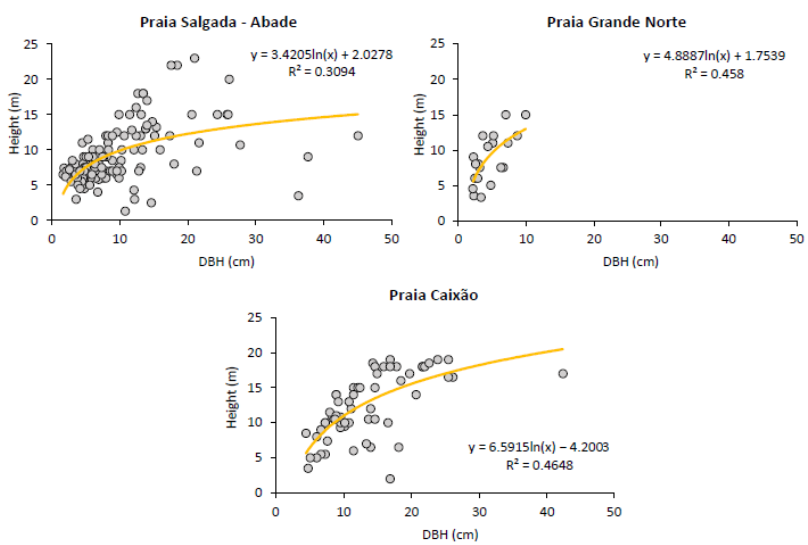
Figure 3. Relationship of the trees ’ height (m) and DBH (cm) on Príncipe Island study sites. In terms of structure, the studied mangrove forests in Maputo Bay had younger/smaller trees compared to the ones on Príncipe Island. Statistical differences were found between Maputo Bay and Príncipe Island when comparing the mean DBH (Kruskal – Wallis; H = 136.075; DF = 41; N = 1349; p < 0.05) and the height (Kruskal – Wallis; H = 542.208; DF = 1; N = 1314; p < 0.05). 3.2.2. Tree Condition In general, the study sites in Maputo Bay presented a higher density of intact trees (class I), the majority being A. marina , Costa do Sol presented 3050 ± 2054.47 ind.ha −1 , Bairro dos Pescadores with 3016.67 ± 682.67 ind.ha −1 , Katembe presented 1928.57 ± 1031.68 ind.ha −1 , Boane with 1687.5 ± 814.04 ind.ha −1 , and Matutuine with 1688.89 ± 761.29 ind.ha −1 , representing 69.32%, 67.92%, 72.19%, 88.82%, and 75.62%, respectively (Figure 4).